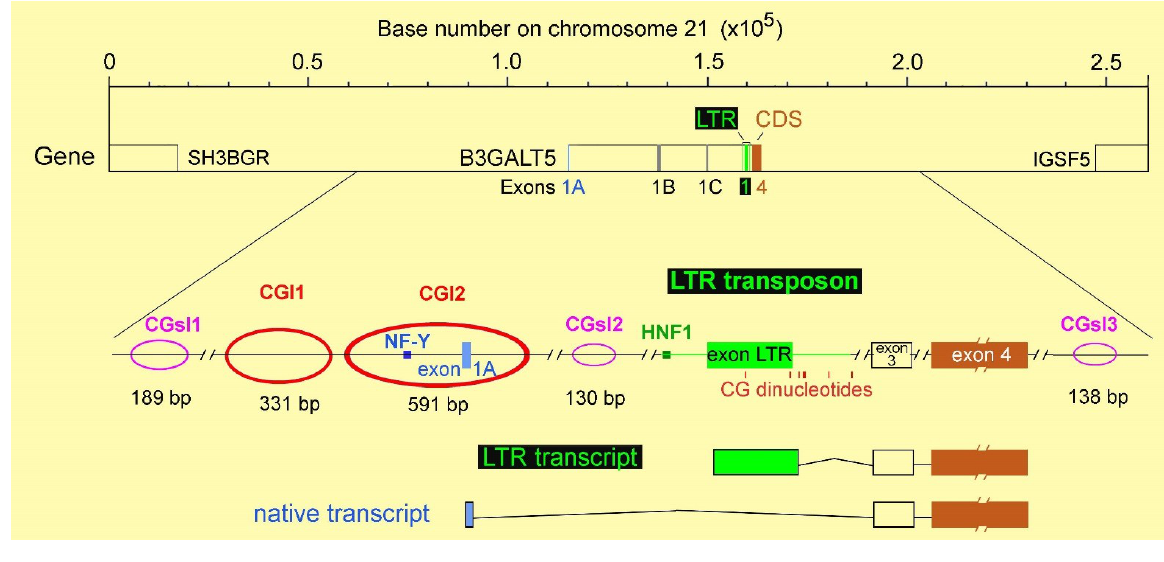
Figure 2. Genomic organization and DNA methylation of the B3GALT5 gene. In the upper part, the genomic sequence of chromosome 21 (0.26 Mbp) encompassing B3GALT5 and intergenic regions is presented. The scale starts at 40.87 Mbp and ends at 41.13 Mbp of NCBI Reference Sequence: NC_000021.8. The LTR transposon starts at bp 41029095 of such a sequence. Between alternative 5'UTRs, exons 1A and 1 (LTR) are the most relevant in various tissues. In the lower part, about 50 Kbp were enlarged to show transcription factor binding sites, CpG islands (CGI, in red), CpG short islands (CGsI) of at least 100 bp (pink), CG dinucleotides present in the LTR transposon and the two main